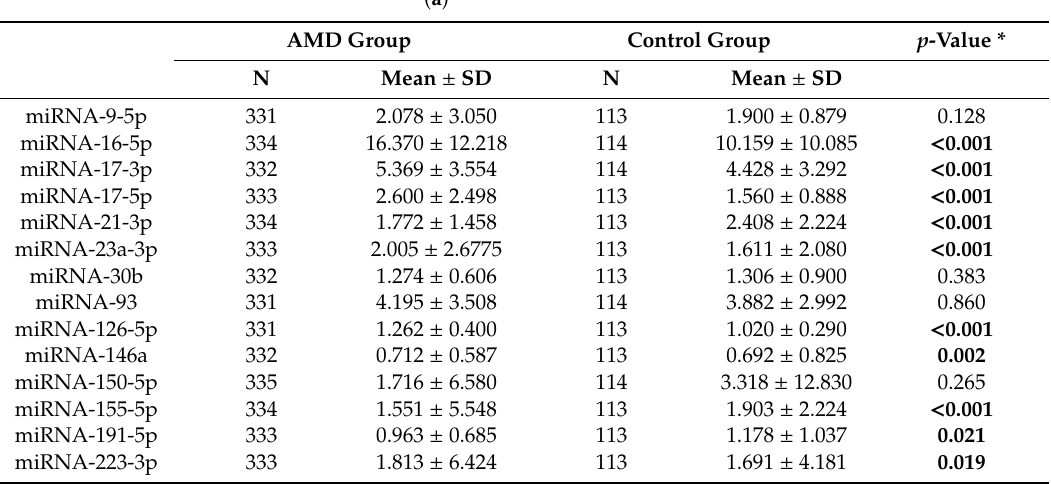
Table 3. ( a ) Plasma miRNA profiles in AMD patients and controls. ( b ) Plasma miRNA profiles in wet and dry